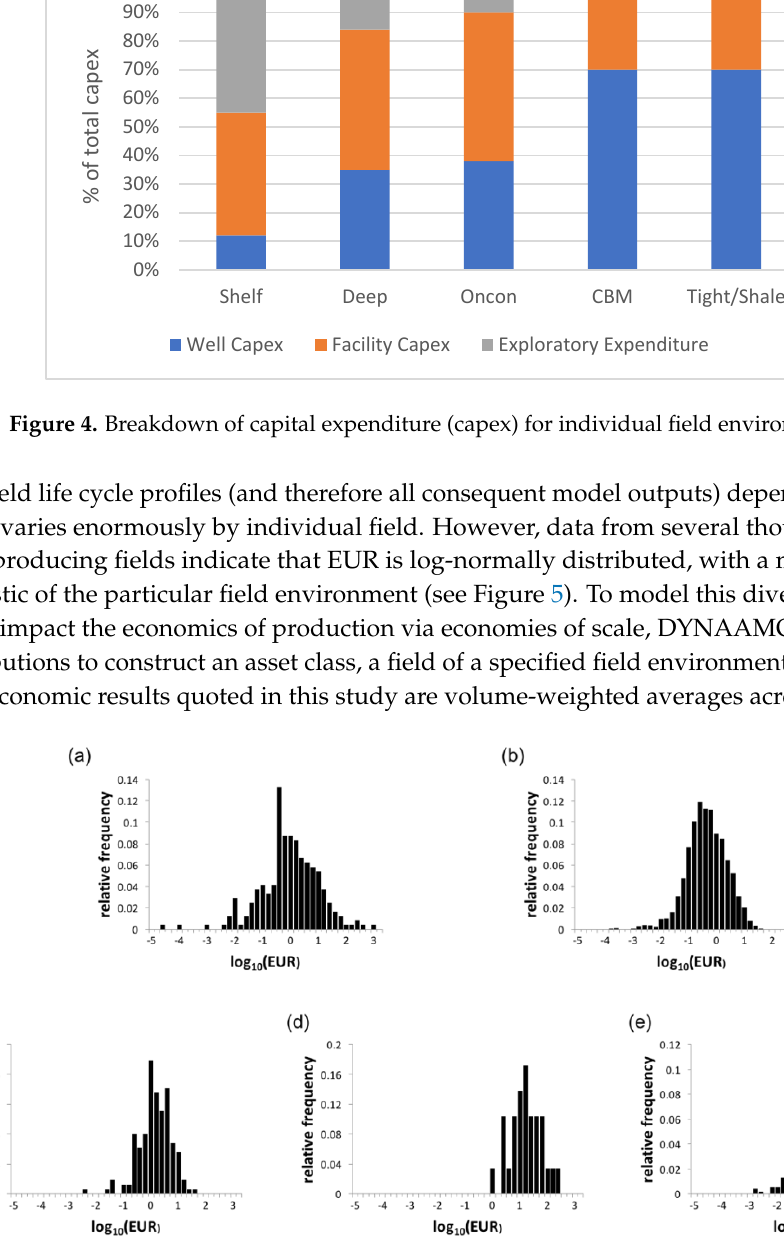
Figure 5. Field size distributions showing the relative frequency vs. the log of the initial 2P EUR (in BCM) for ( a ) onshore conventional, ( b ) shelf, ( c ) deep offshore, ( d ) CBM, and ( e ) tight/shale. The bin width is 0.2. The number of fields used to derive the distributions is: tight/shale = 523, CBM = 29, onshore conventional = 241, shelf = 2534, deep offshore = 162.